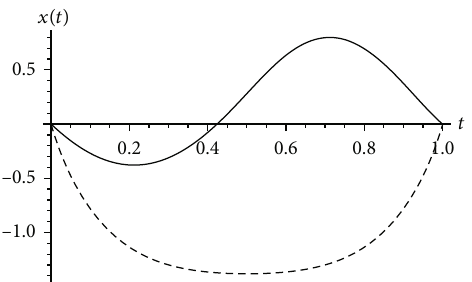
Figure 18: Graphs x ð t Þ for solutions of problem (31) and (37), α ≈ − 3 : 378 , α ≈ − 12 : 3317 (dashed).